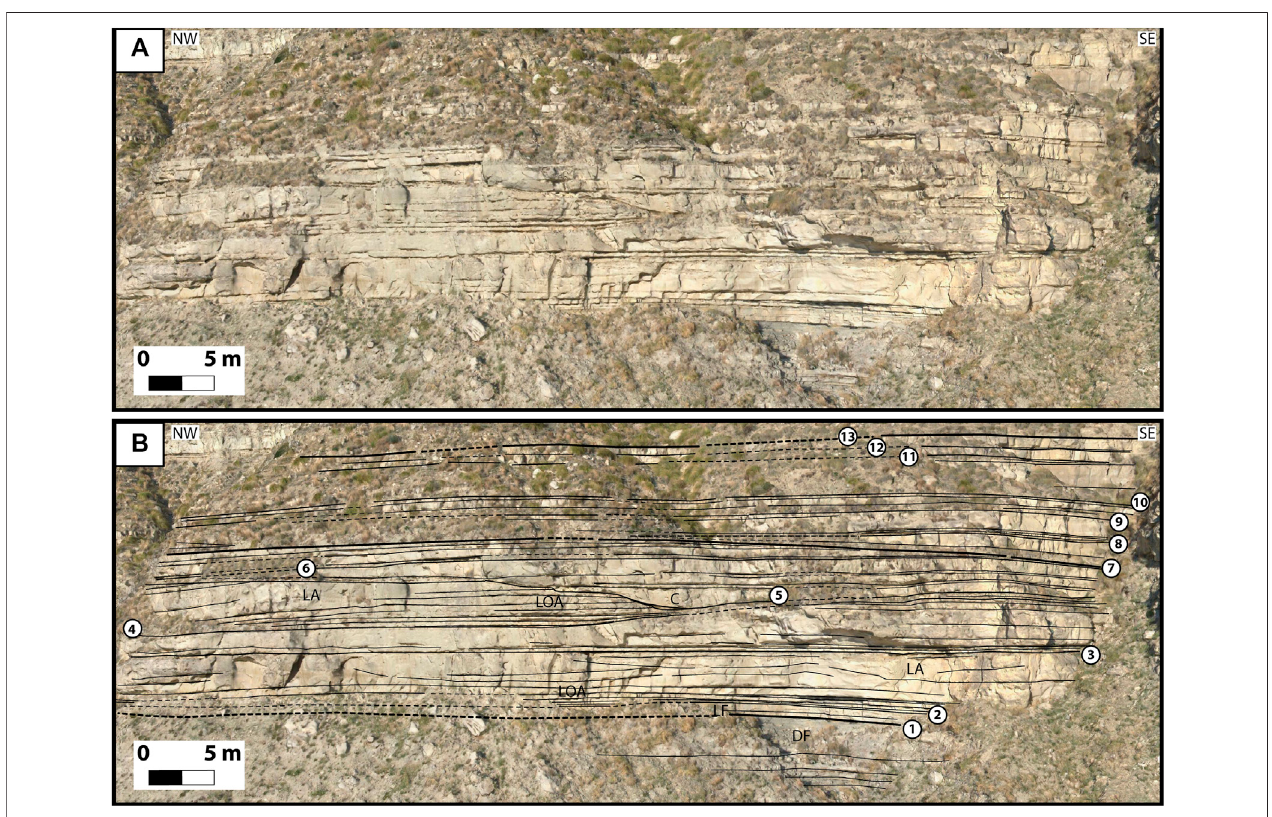
FIGURE9| StratigraphicarchitectureoftheSaettaareaillustratingstackedlobes. (A) Panoramicviewextractedfromthe3Doutcropmodel. (B) Themainsurfaces discussed in the text (1 – 13) are highlighted. Surfaces at the top of lobe are represented by thicker dark lines (e.g. Lines 7 and 13). Full interpretation is presented in Figure 10 . (C) Channel, (Le) Levee, (LA) Lobe axis, (LOA) Lobe off-axis, (LF) Lobe fringe, (DF) Distal lobe fringe.